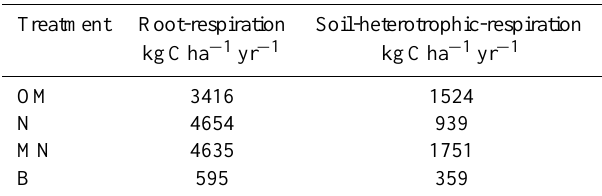
Table 1. Modeled soil CO 2 flux with autotrophic respiration by plant roots and heterotrophic respiration by soil